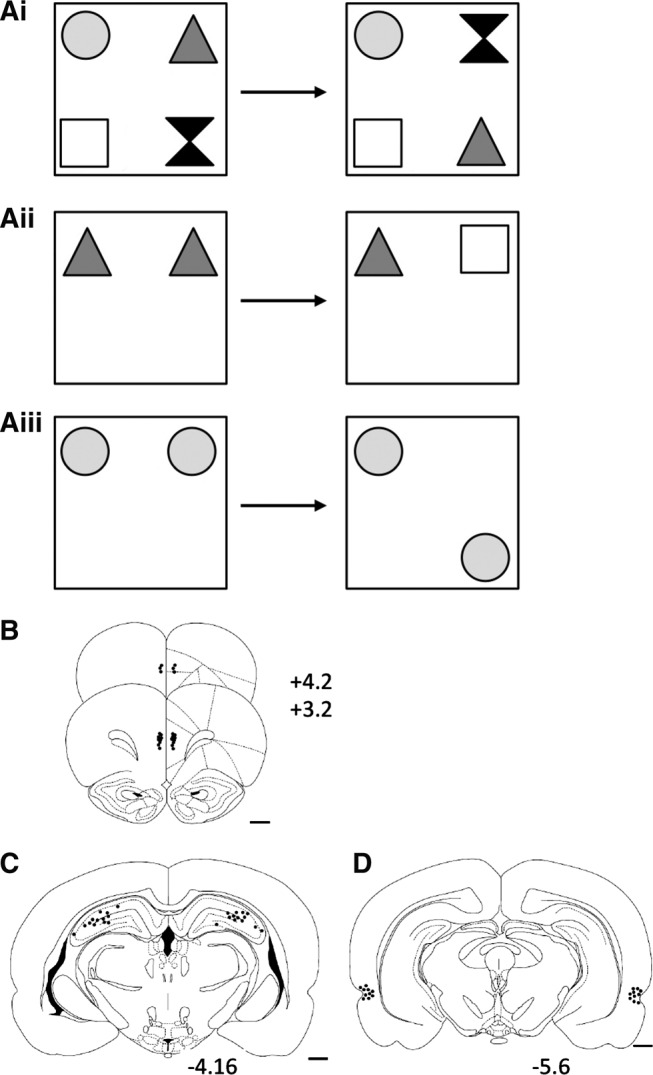
Diagram of the three object recognition memory tasks and of the histology of the individual infusion sites. (Ai) Object-in-place (OiP) task. (Aii) Novel object recognition (NOR) task. (Aiii) Object location (OL) task. (B) Bilateral mPFC group. (C) Bilateral HPC group. (D) Bilateral PRH group. The numbers correspond to the approximate position from bregma (Paxinos and Watson 1998). Scale bar, 1 mm.